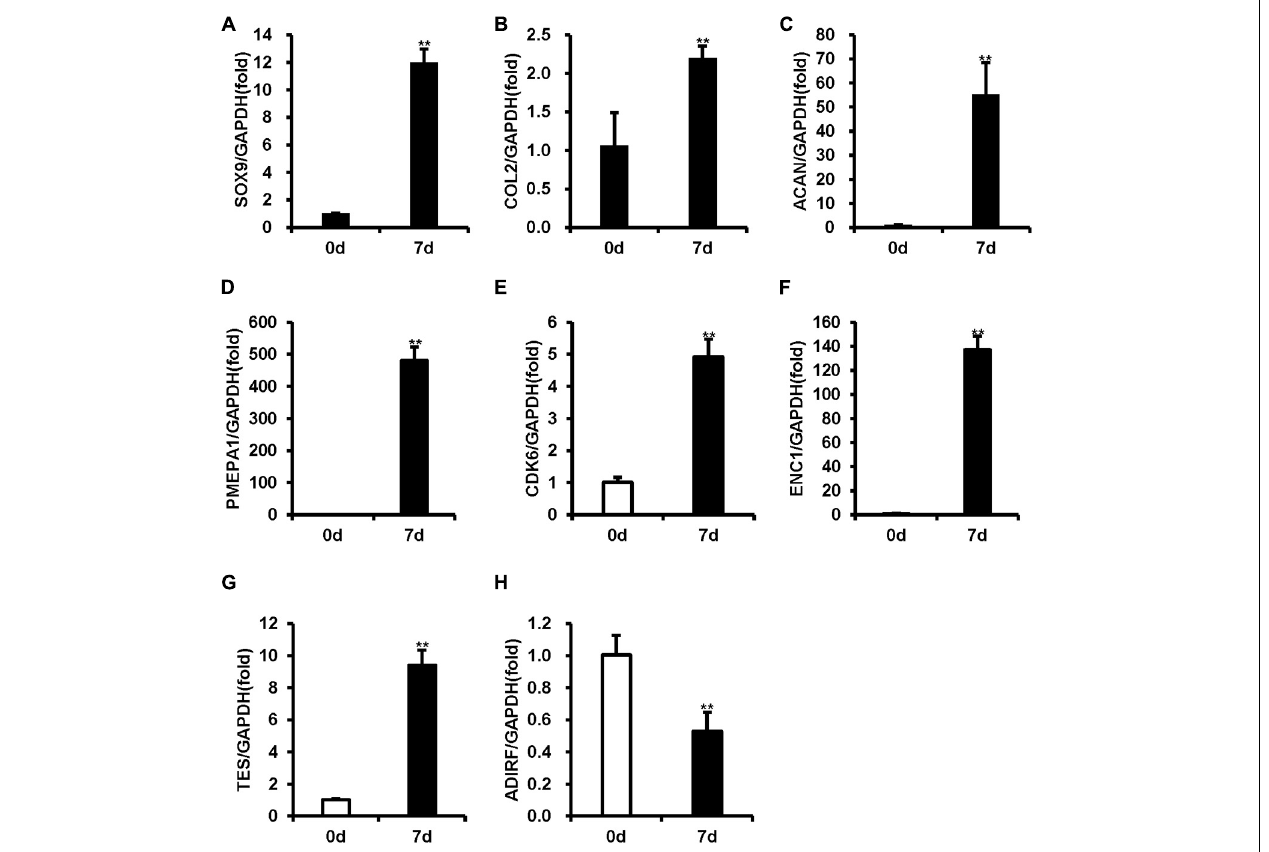
FIGURE 1 | The mRNA levels were measured using real-time RT-PCR in BMSCs during chondrogenic differentiation. (A–C) The expression of SOX9, COL2, and ACAN was upregulated after 7 days of chondrogenic induction. (D–G) PMEP1, CDK6, ENC1, and TES expression increased after 7 days of chondrogenic induction. (H) ADIRF expression decreased after 7 days of chondrogenic induction. GAPDH acted as an internal reference. Statistical significance was determined by Student’s t -test. SD is represented by bars. ( n = 3). ** p < 0.01.